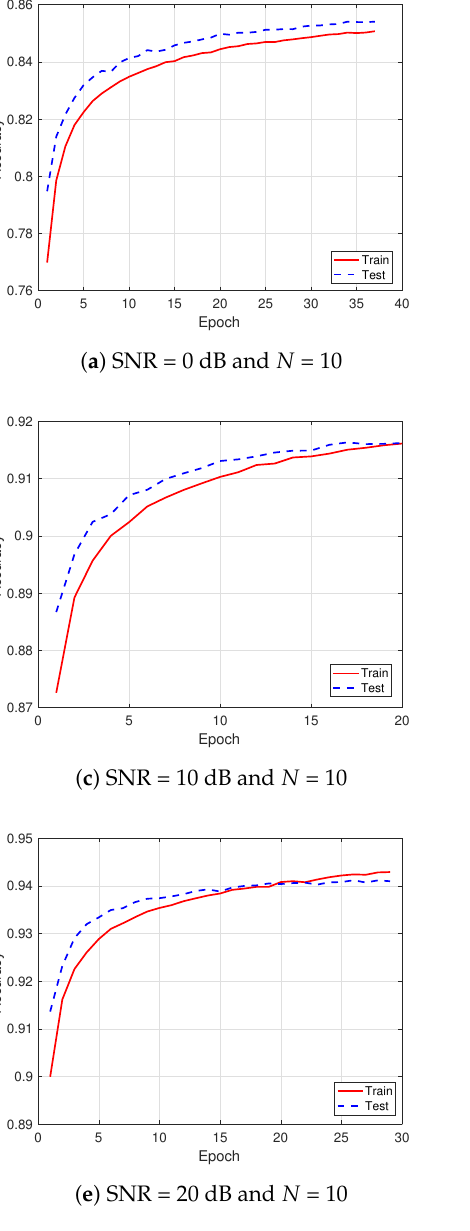
Figure 4. Accuracy of the deep learning based scheme when SNR